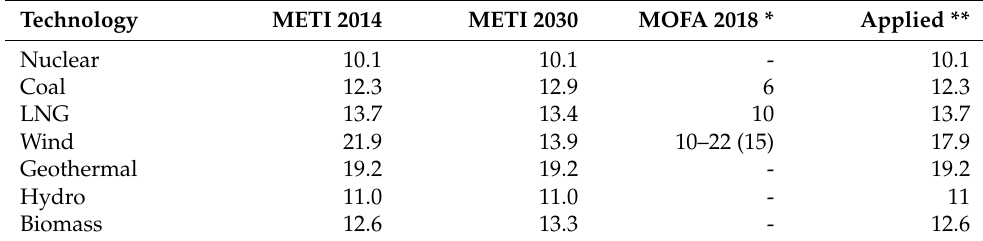
Table 4. Cost of Electricity Generation